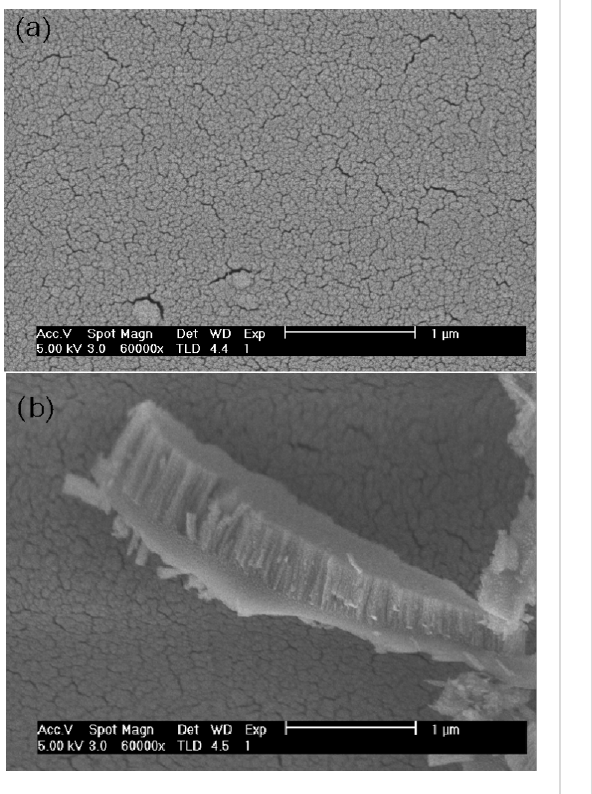
Figure 2: SEM images of (a) the top surface and (b) the cross-section of the magnetron sputtered TiO 2 films grown on SiN x /SLG after annealing at 450 °C.